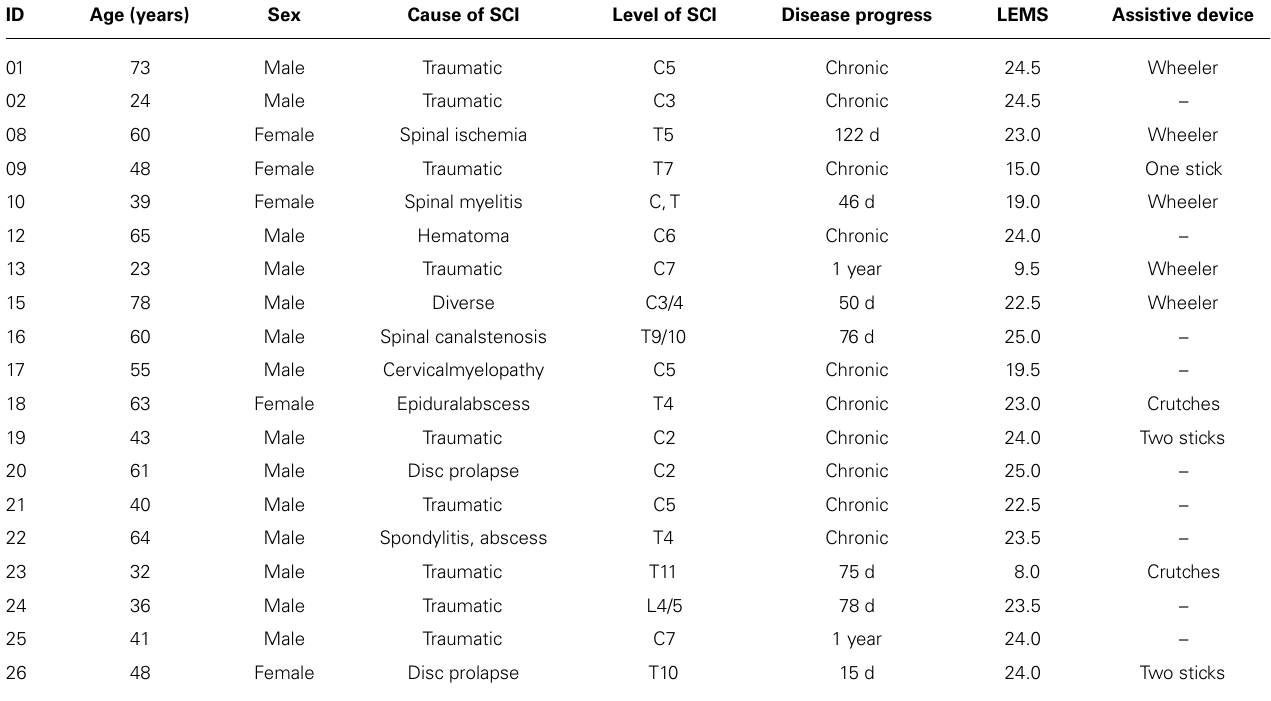
LEMS = mean value of left and right lower extremity motor score (max =